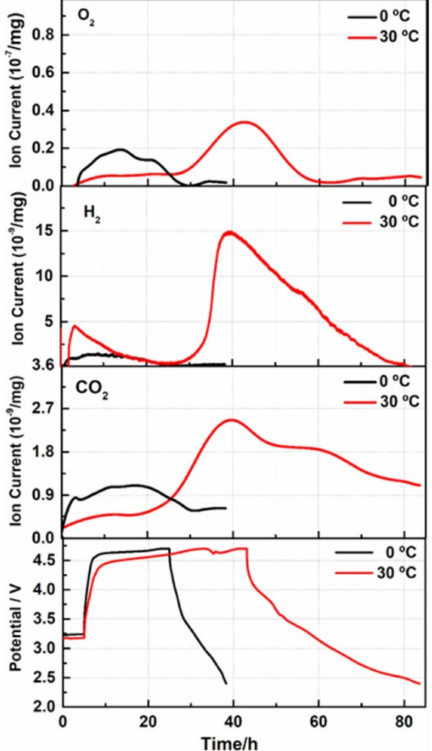
Figure 4. Evolution of gases O 2 , H 2 , and CO 2 with time during the 1st charge–discharge cycle of Li 2 MnO 3 electrodes (shown in the bottom chart) measured by OEMS at 0 ◦ C and 30 ◦ C, as indicated. Since during 2nd to 7th initial cycles, less gas was evolved compared to the 1st one, the corresponding ion currents could not be adequately measured because of the instrumental limitations of OEMS. The upper cut-o ff voltage was 4.7 V in these